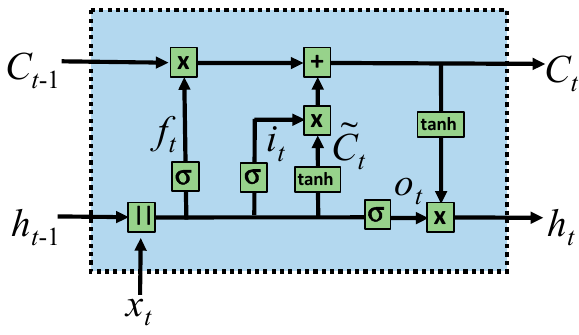
Figure 8. The structure of the LSTM network.